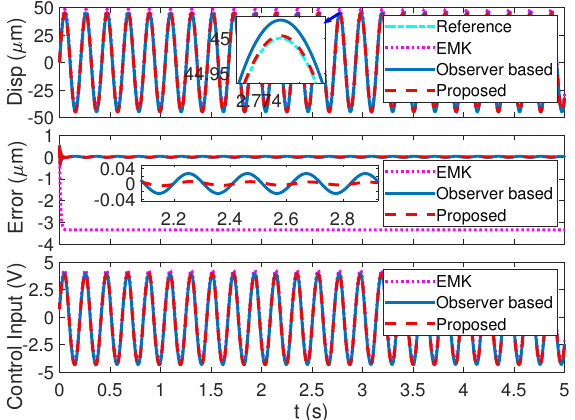
Figure 8. Simulation results of the three control methods (30 rad/s).